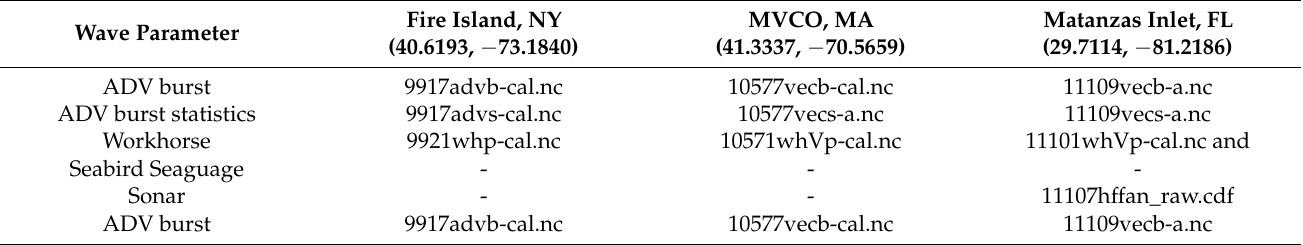
Table 1. Filenames containing the datasets used to obtain near bottom and surface wave measurements.